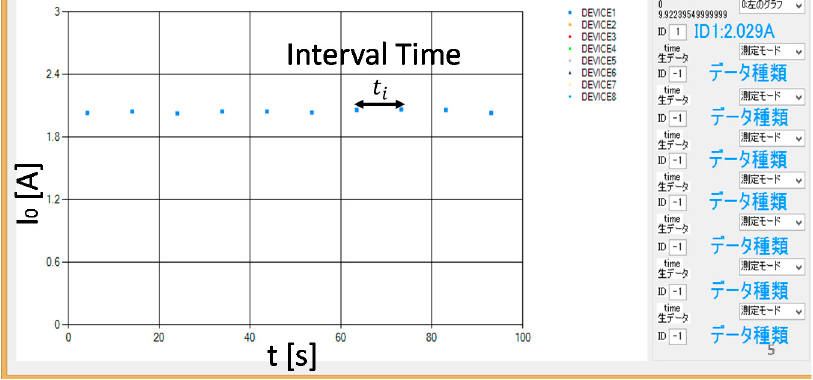
Figure 5. Measured DC current by the DCC Beat Sensor.